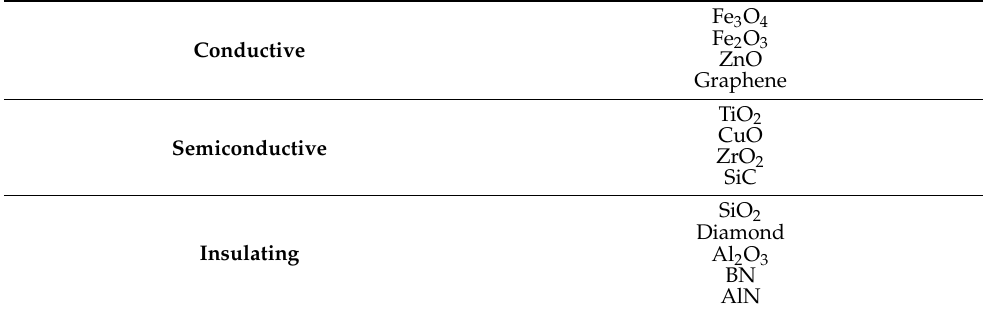
Table 5. Classification of nanoparticles in function of their electric conductivity.